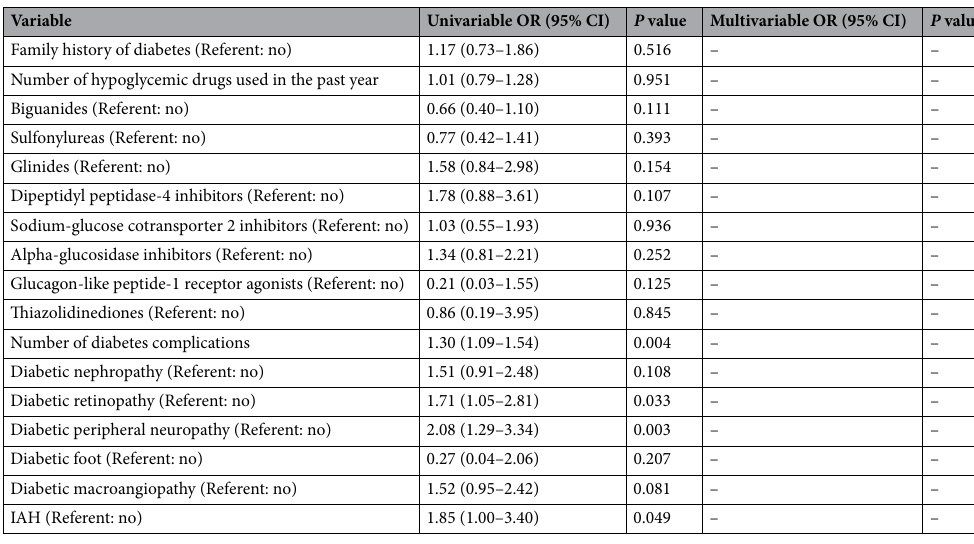
Table 5. Univariable OR and multivariable OR of patients with fear of hypoglycemia. HbA1c, glycated hemoglobin; BMI, body mass index; CNY, China Yuan; USD, US dollars; IAH, impaired awareness of hypoglycemia; OR, odds ratio; CI, confidence interval. Hypoglycemia was defined as a plasma glucose level ≤ 3.9 mmol/L in patients with diabetes and severe hypoglycemia was defined as any hypoglycemic episode that led to seizures, loss of consciousness, and/or urgent medical attention. The number of hypoglycemic episodes was self-reported by patients on a questionnaire based on blood glucose self-monitoring diaries and their own